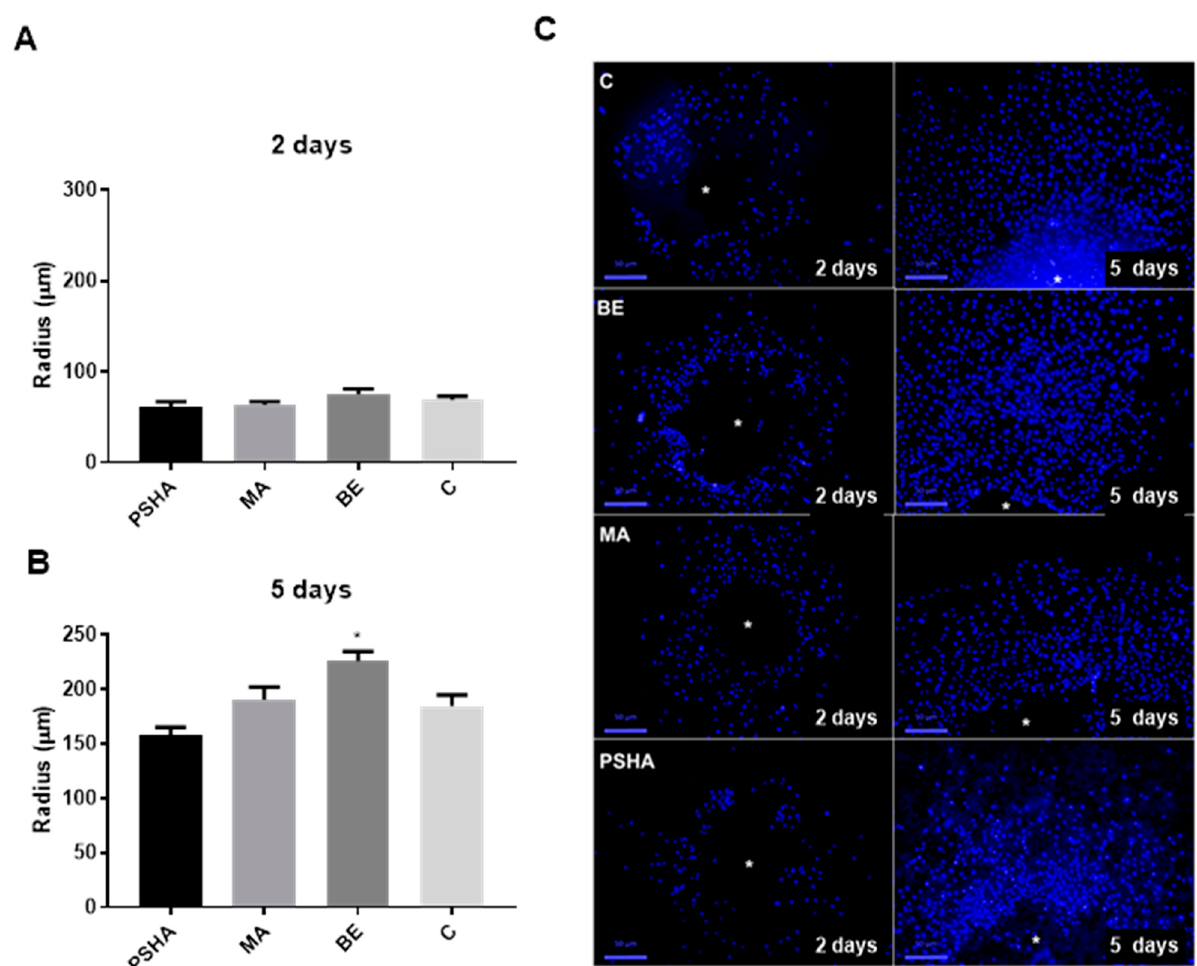
Figure 7. Estimation of migration/proliferation over the titanium surfaces, through the measurement of the radius of the distance between the edge of the aggregate and the most distant cells in 2 days ( A ) and 5 days ( B ). ( C ) The cell halo which was seen when aggregate was removed due to sample processing and which was used for quantitative analysis. This is evident that cell density increased with the time of incubation. A white point indicates where the aggregates were. * Indicates significant difference from all other groups ( p < 0.05). Bars indicate mean ± SEM of three independent tests with three biological replicates each.